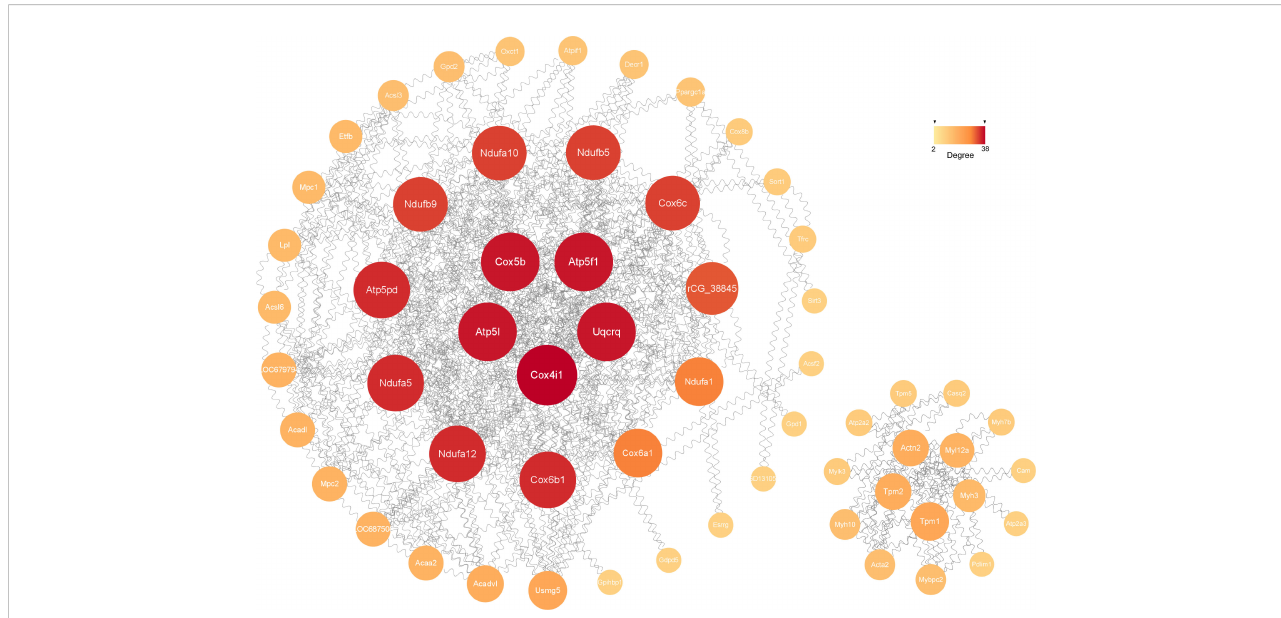
FIGURE 6 The signi fi cant module analysis of PPI network. The color and size of sections were both quanti fi ed corresponding to the degree (node connections, range of 2-38).